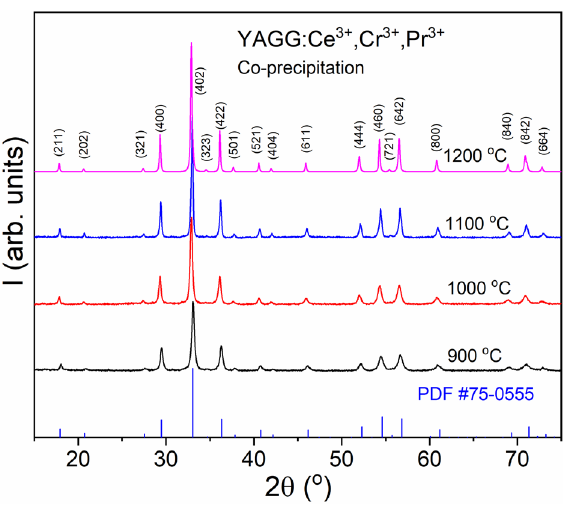
Figure 1. XRPD patterns of YAGG:Ce 3+ ,Cr 3+ ,Pr 3+ annealed at different temperatures in